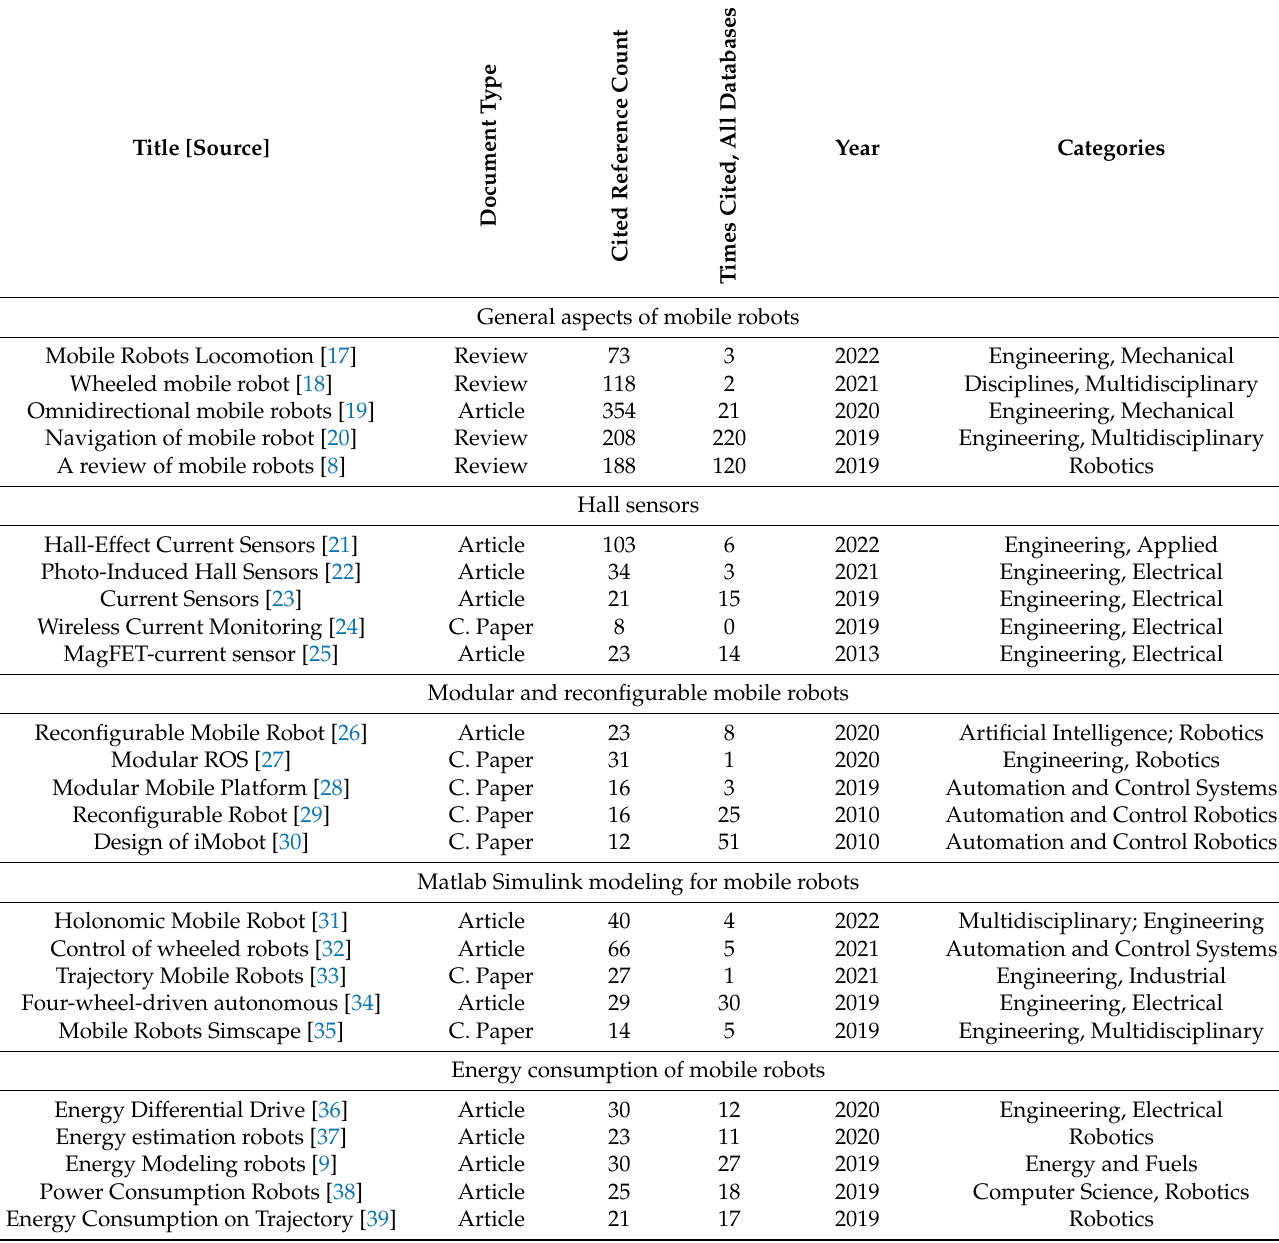
Table 1. References of the state of the art on